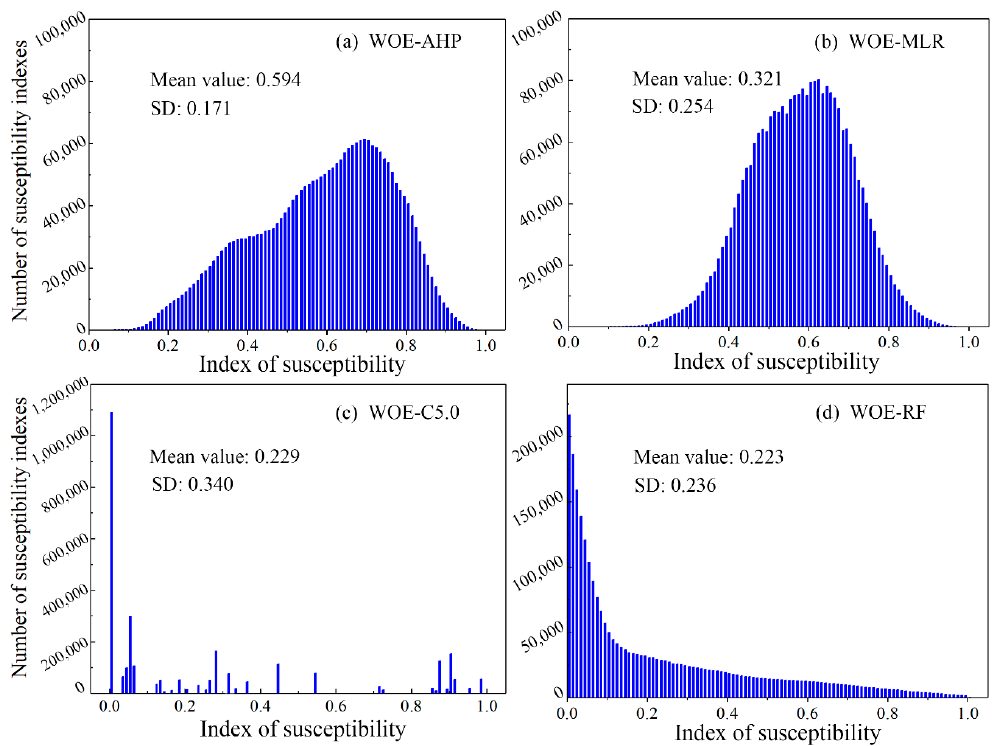
Figure 10. Collapse susceptibility indexes distribution of WOE-AHP ( a ), WOE-MLR ( b ), WOE-C5.0 ( c ) and WOE-RF ( d ).